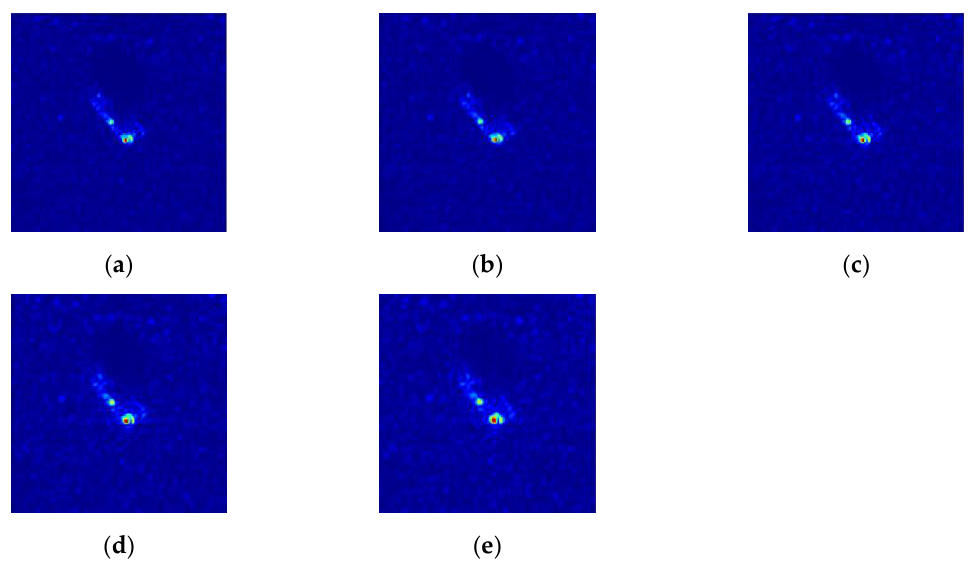
Figure 16. MSTAR data at different resolution. ( a ) 0.3 m × 0.3 m, ( b ) 0.4 m × 0.4 m, ( c ) 0.5 m × 0.5 m, ( d ) 0.6 m × 0.6 m, ( e ) 0.7 m × 0.7 m.